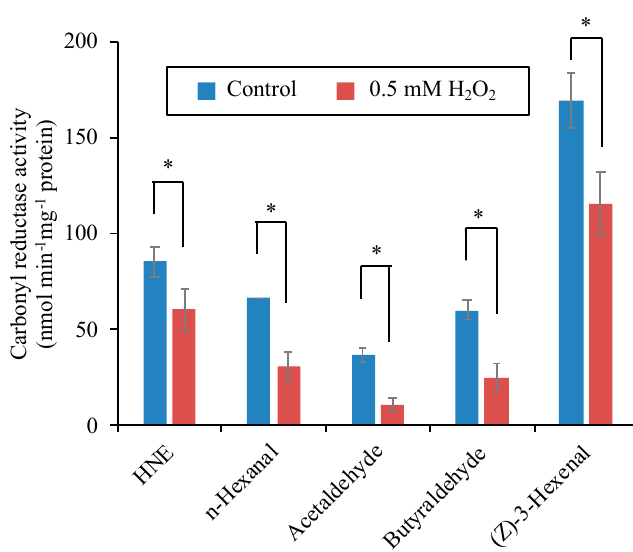
Figure 9. E ff ects of H 2 O 2 on the NADPH-dependent carbonyl reductase activity for di ff erent substrates. Proteins were extracted from the untreated tobacco BY-2 cells. H 2 O 2 at 0.5 mM was added to the cell extracts, and after 10-min incubation, the enzyme activity for the indicated substrate were determined as described in the Materials and Methods section. Each point represents the mean of three independent experiments and the error bars of the SEM. Asterisks indicate a statistical di ff erence ( p < 0.05, Student’s t